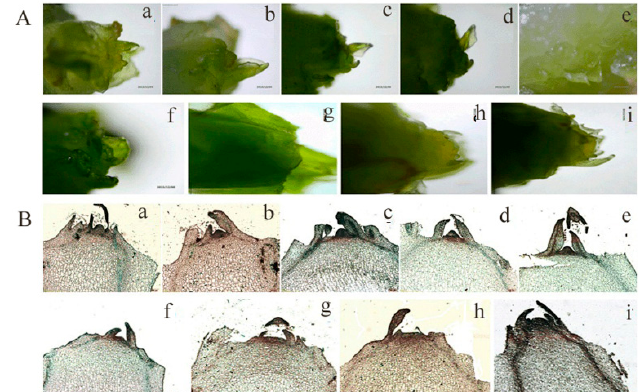
Figure 2. Change of flower bud differentiation of lettuce after high temperature treatment of 33/25 °C. ( A ) Representative images of stem tips under 20/13 °C (day/night) (control) and 33/25 °C (day/night) treatment for 40 days. Representative images of stem tip growth under control (b–e) and high temperature treatment (f–i) for 8, 24, 32 and 40 days, and (a) stem tip growth at Day 0. ( B ) The progress of flower bud differentiation. Representative images of morphology of flower bud under control (b–e) and high temperature treatment (f–i) for 8, 24, 32 and 40 days, and (a) stem tip growth at Day